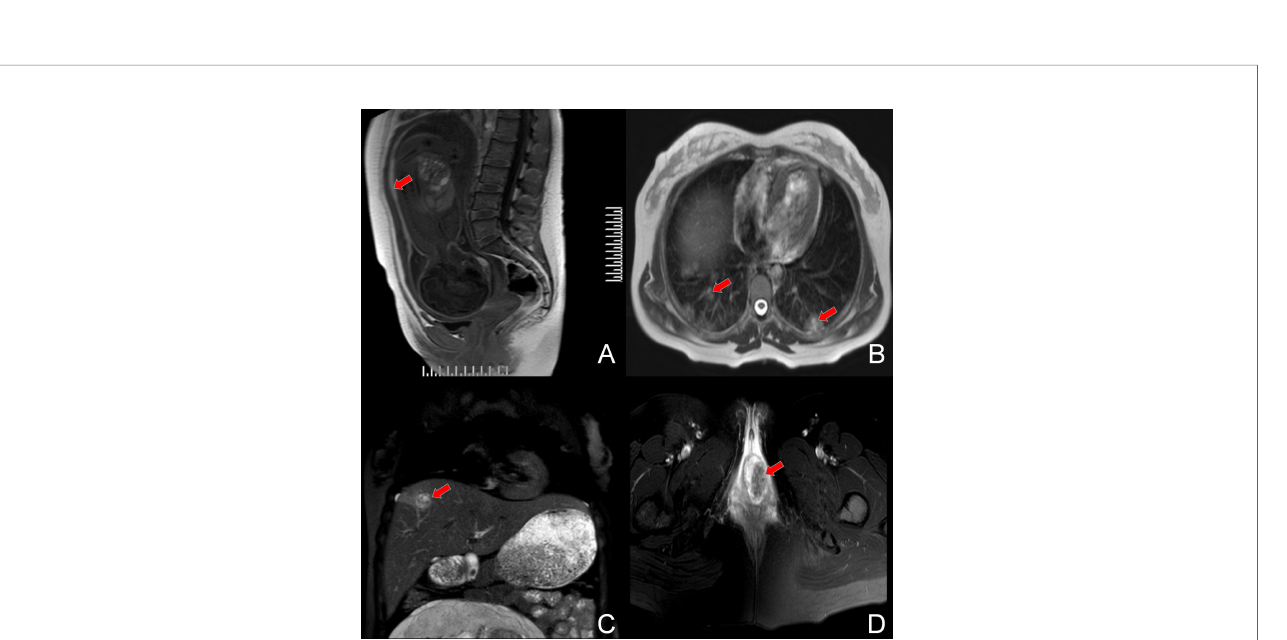
FIGURE 2 | MRI fi lm showing the original lesion in the anterior uterine wall (A) and the metastasis lesion in the bilateral pulmonary tissue (B) , right lobe of the liver (C) , and the vagina (D)